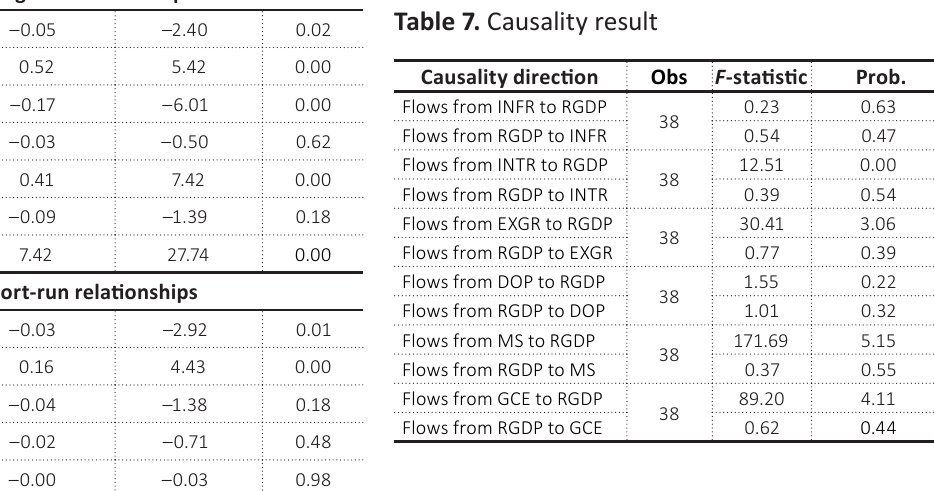
Table 7 indicates the causality test result conduct-